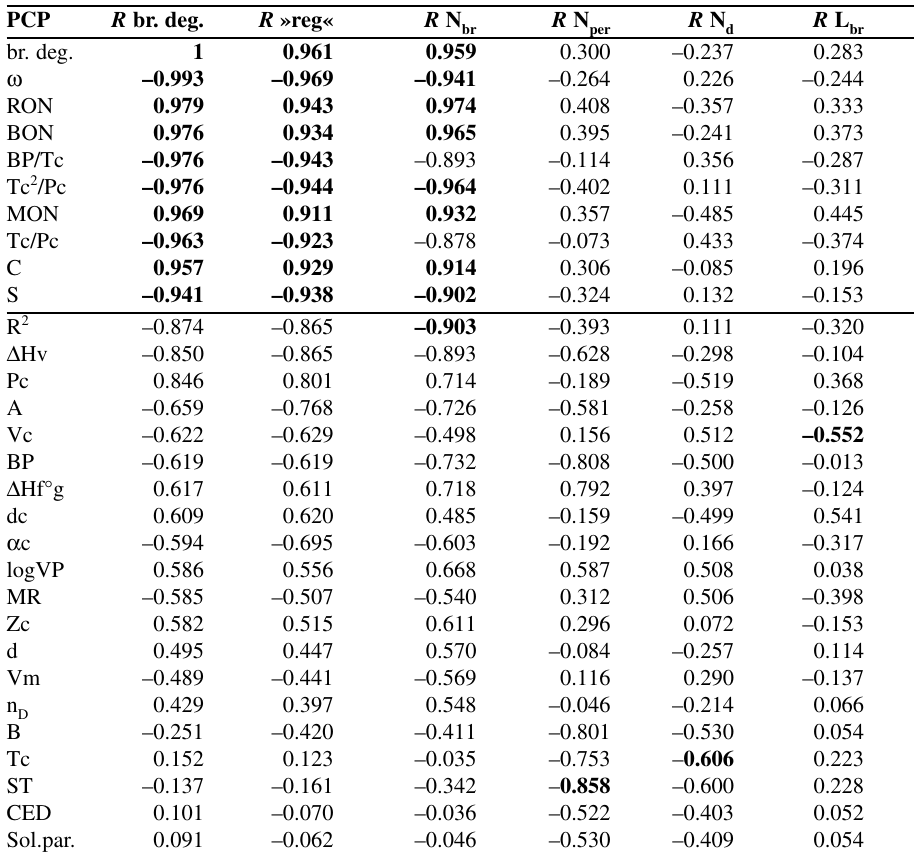
Table 2. Correlation of physicochemical properties of octanes with the branching degrees presented in Table 1 ( R br. deg.) sorted by | R | , with the »regular« equidistant sequence of octane isomers ( R »reg.«), with the number of branches ( R N ), with the peripheral number ( R N ), with the distance number ( R N ) as well as br per d with the size of the largest branch ( R L br